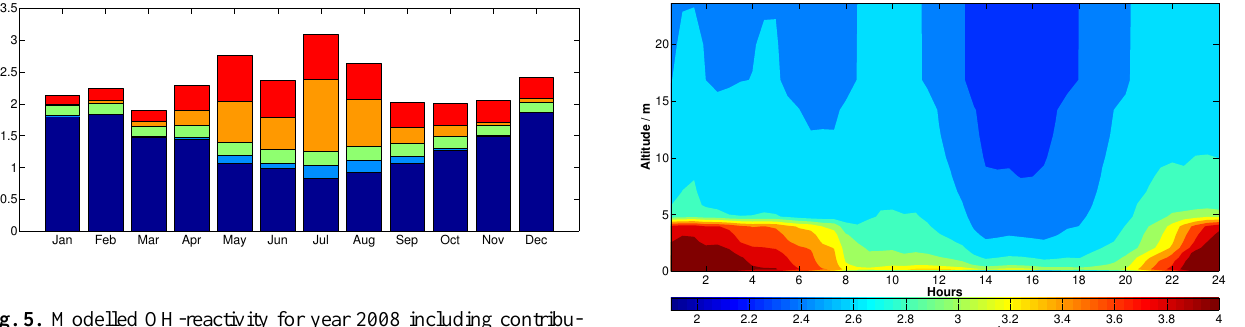
Fig. 5. Modelled OH-reactivity for year 2008 including contribu- tions from inorganic compounds (dark blue), isoprene (light blue), methane (lime), monoterpenes (orange) and other VOCs (red).